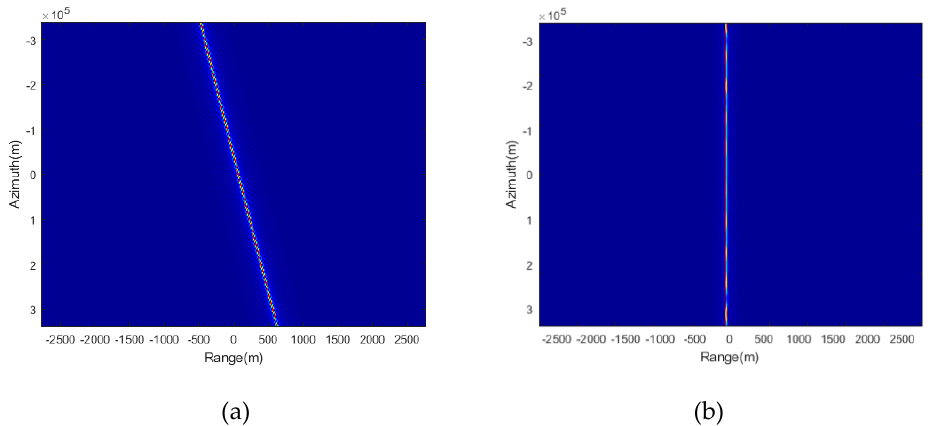
(GKT) and Generalized Dechirp Process (GDP); (b) with the GKT and GDP. Figure 7. The echo signals after range compression: ( a ) without the Generalized Keystone Transform Figure 7. The echo signals after range compression: (a) without the Generalized Keystone Transform